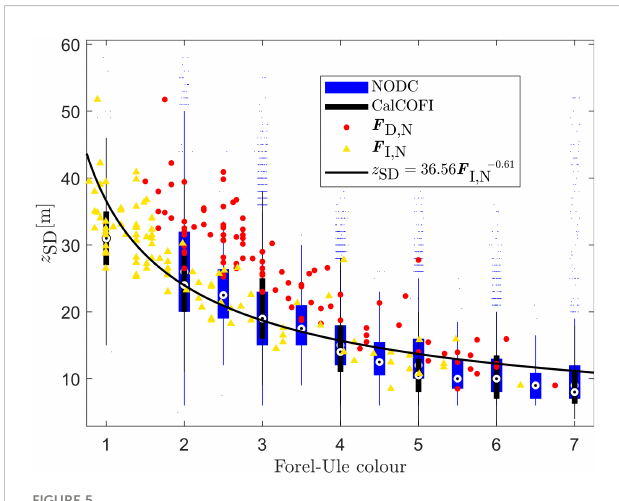
FIGURE 5 Comparison of Secchi depth ( z SD ) versus Forel-Ule colour ( F ) data collected on AMT (red circles and yellow triangles) with historical datasets from NODC and CalCOFI. Note that F I,N is a synthetic quantity that derives from F D,N and the model in Pitarch